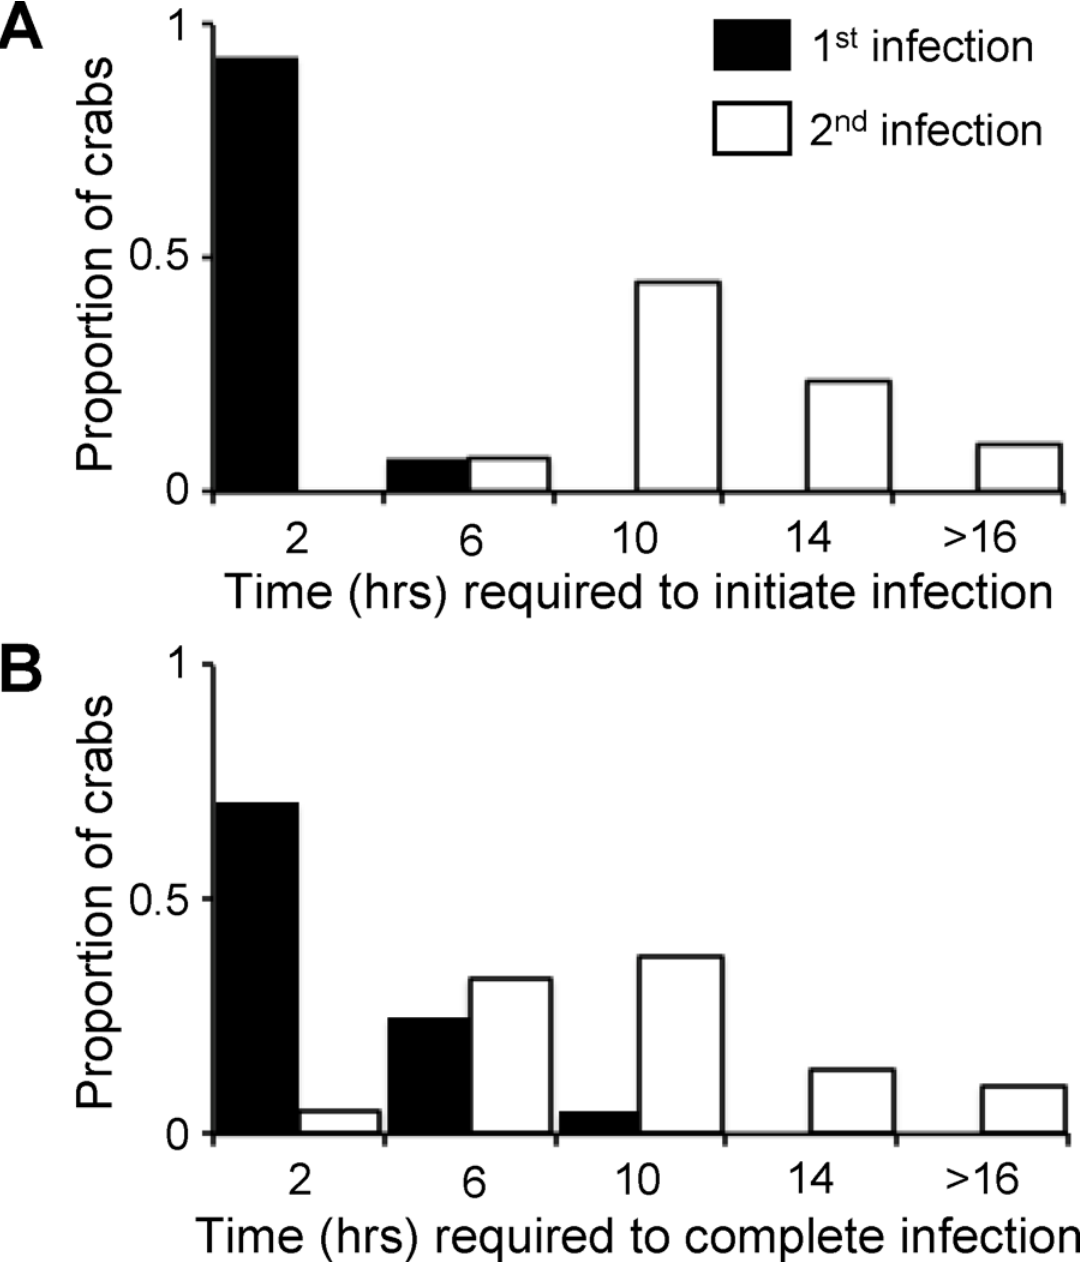
Fig 5. Time to initiate and complete colonization of uninfected and infected hosts. A comparison of the time required by searching Tunicotheres moseri adult crabs to (a) initiate and (b) complete colonization of ascidian hosts Styela plicata when crabs were offered a vacant (1 st infection) or occupied (2 nd infection)